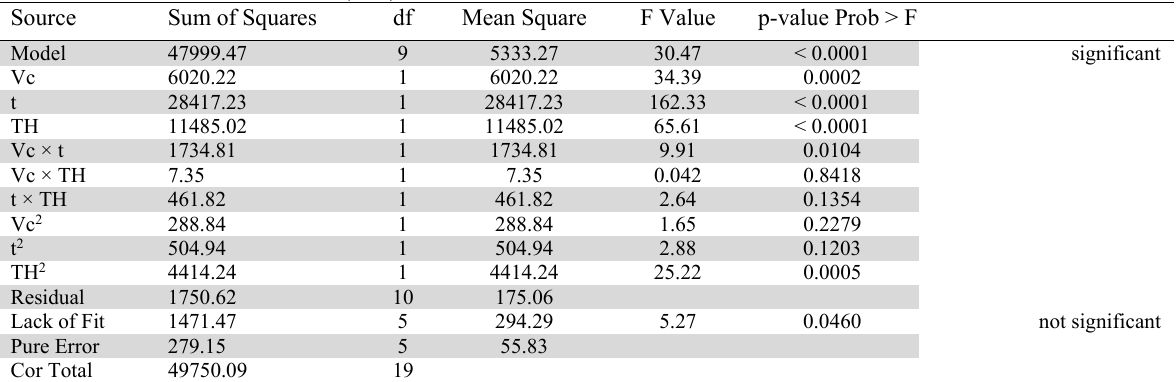
ANOVA results for tool wear (VB)